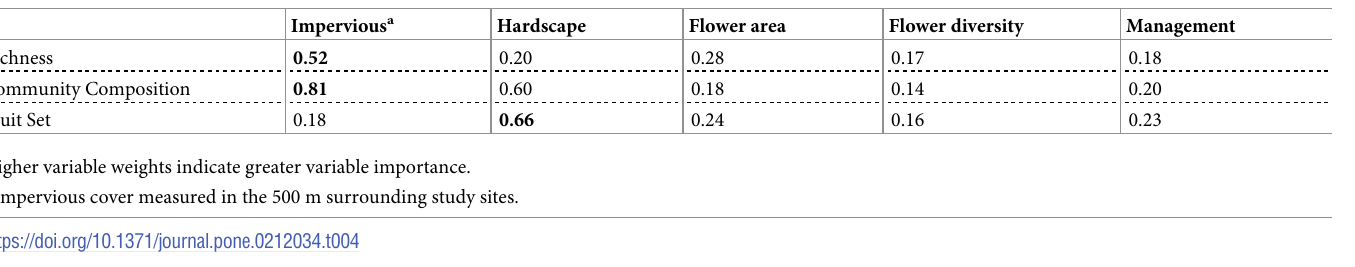
Table 4. Variable weights calculated for each explanatory variable in the full model for bee richness, community composition, and fruit